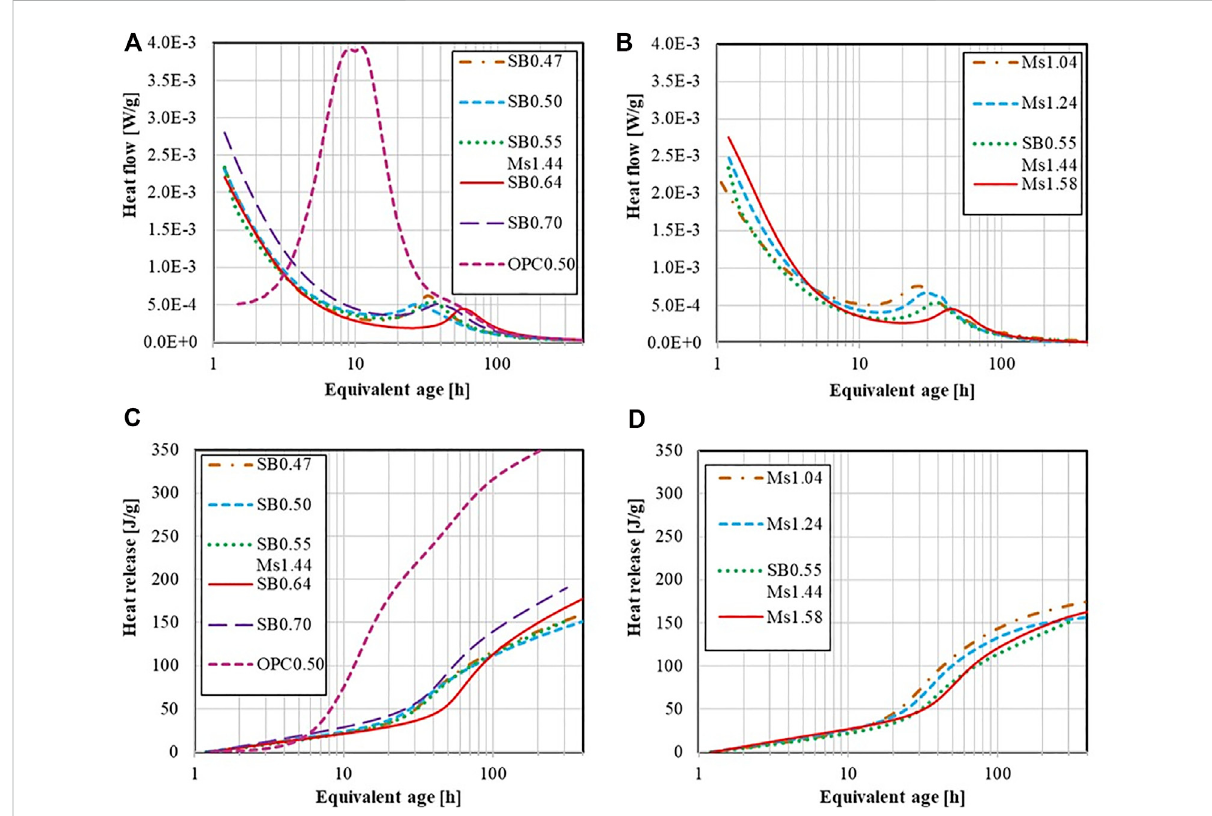
FIGURE 3 Heat fl ow of AASF pastes with different S/B (A) , with different M s (B) ; Cumulative heat release of AASF pastes with different S/B (C) and with different M s (D)